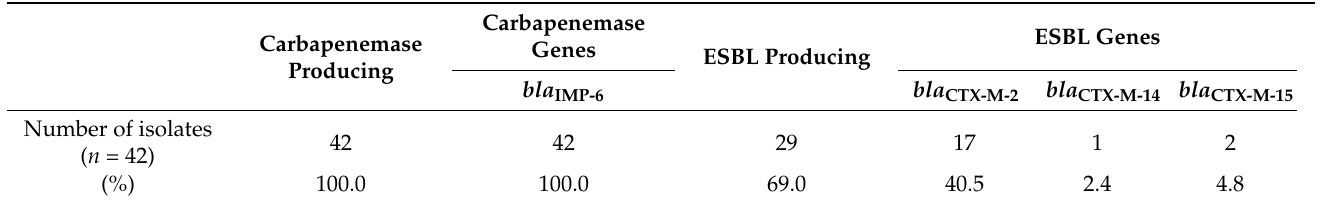
Table 2. Characteristics of carbapenemase and ESBL among 42 strains of IMP-6-producing E. coli .